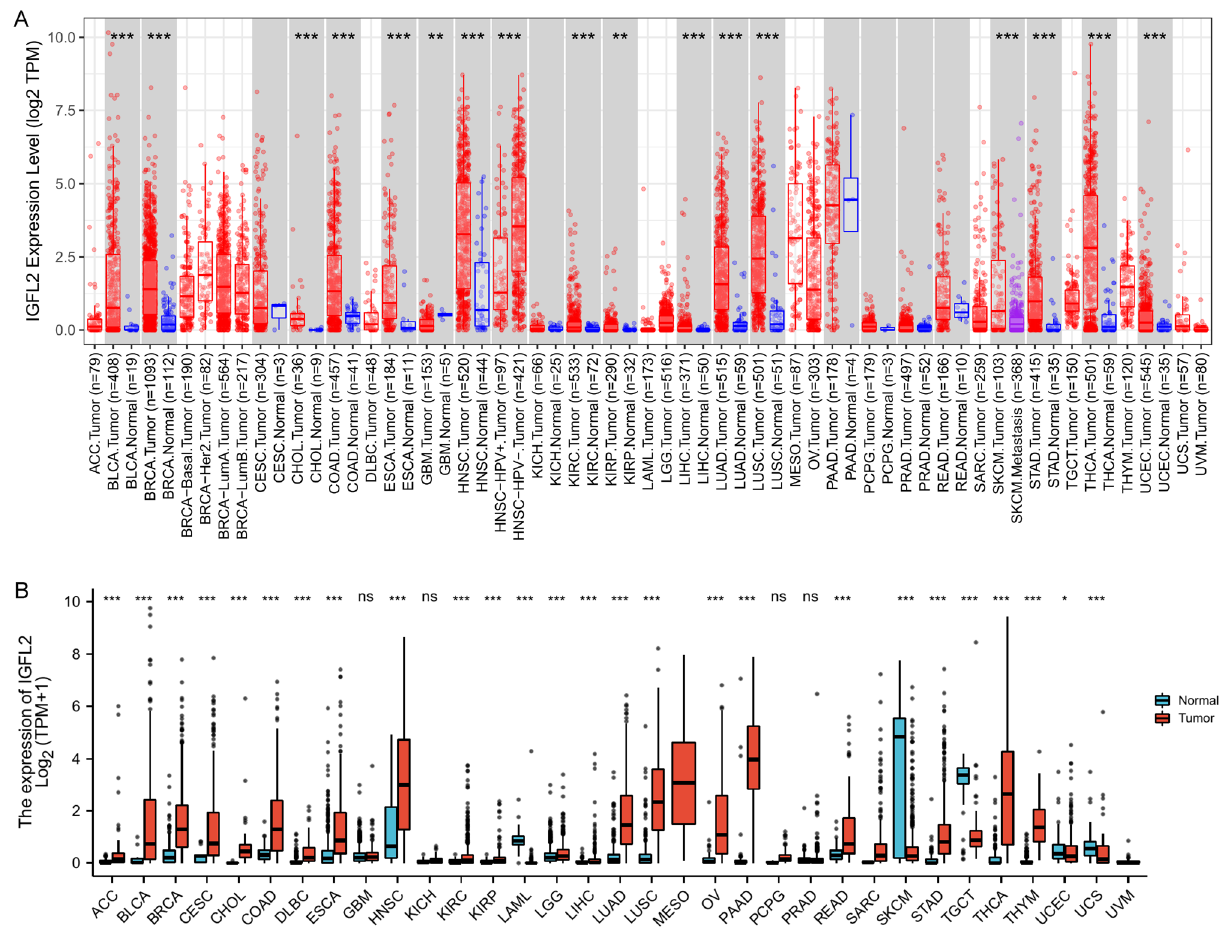
Figure 1. Expression of IGFL2 between normal and tumor tissues ( A ) IGFL2 expression profiles from TIMER. ( B ) IGFL2 expression profiles from TCGA and GTEx databases. *** p < 0.001 ** p < 0.01 * p <